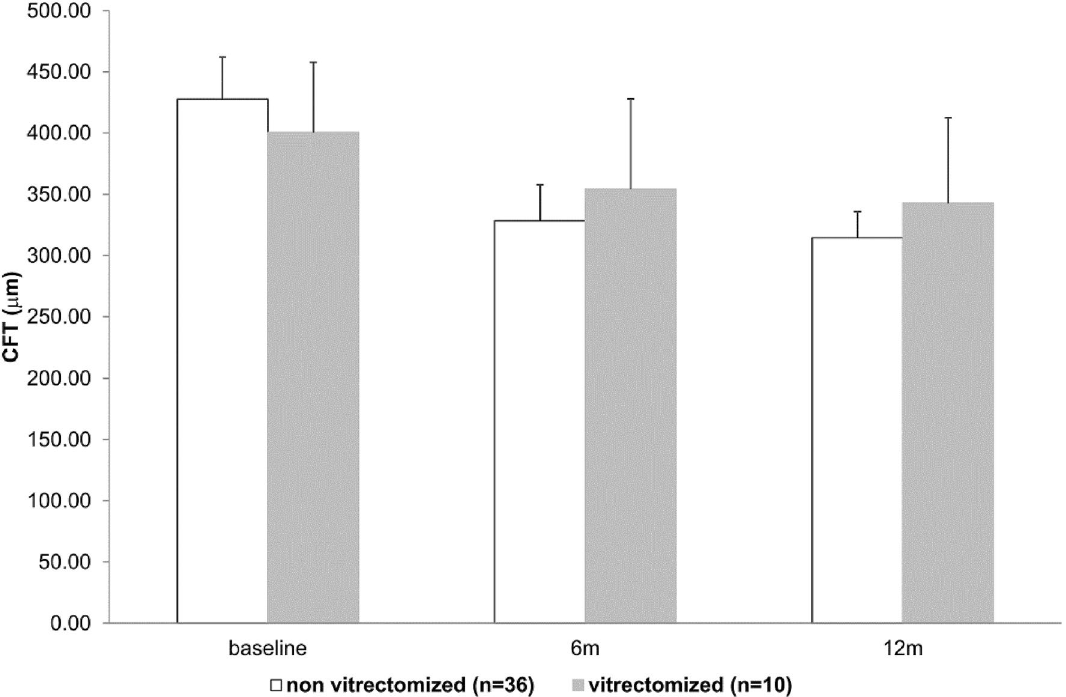
Figure 2. CFT evolution from baseline to the end of follow-up. Mean ± 95% CI. p = ns at each time point using the Mann–Whitney U test.